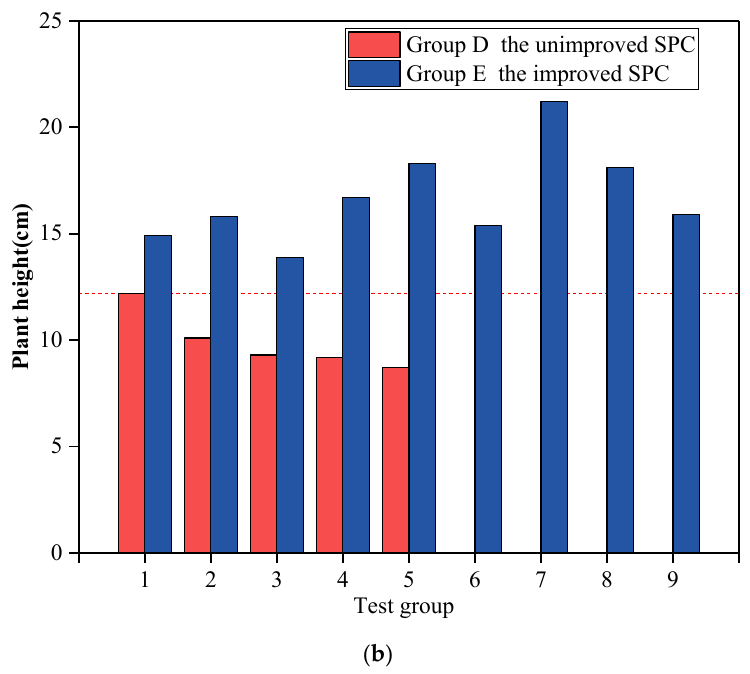
Figure 6. Plant growth with SPC before and after improvement. ( a ) Germination rates when using SPC before and after improvement. ( b ) Plant heights when using SPC before and after improvement.